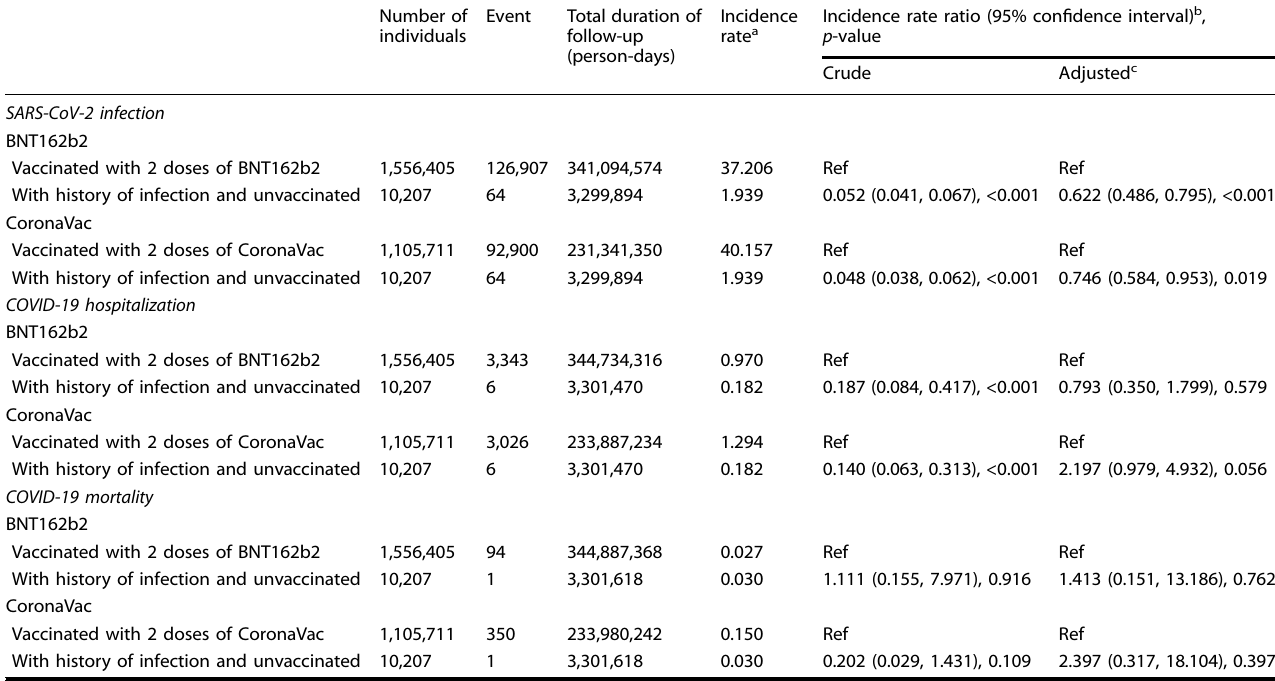
Table 3. Incidence rate ratios of study outcomes between vaccine recipients not previously infected and non-vaccine recipients with a previous